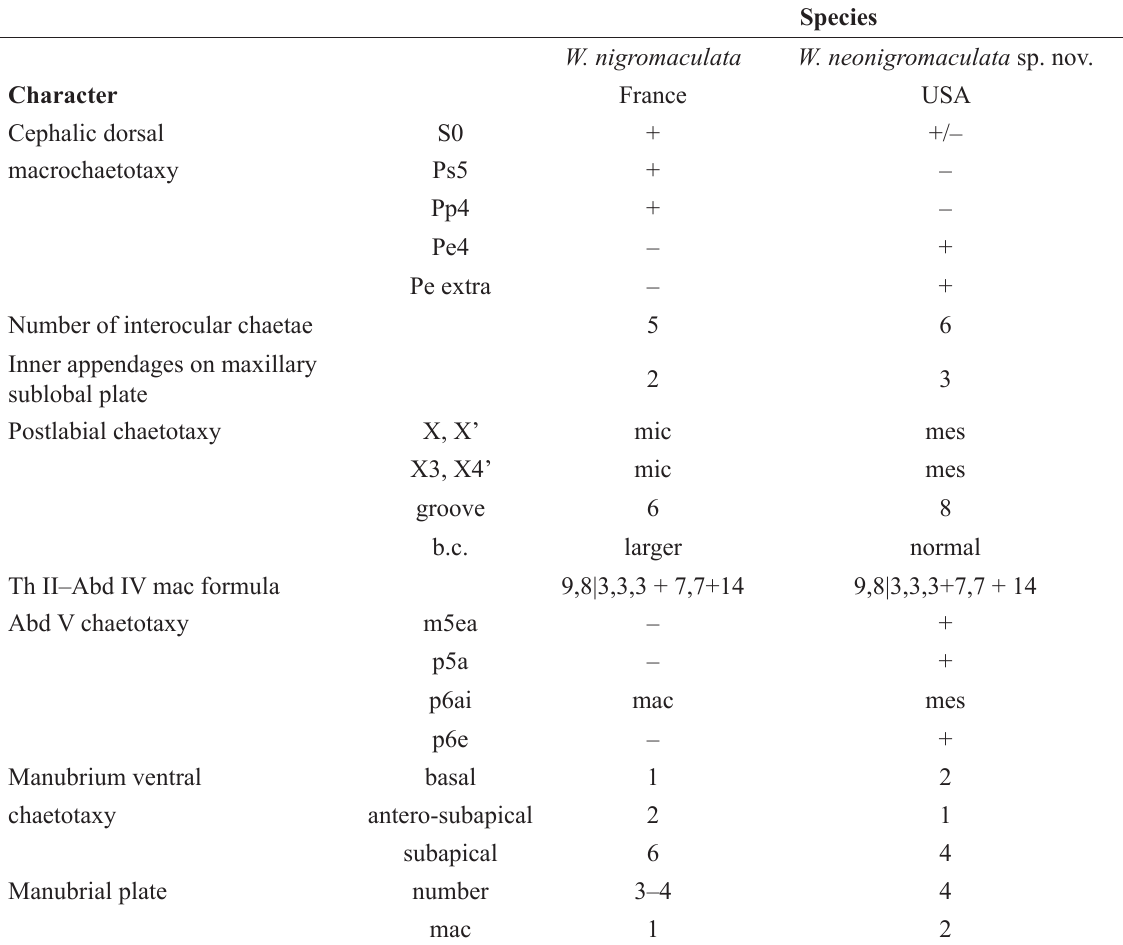
Table 2. Morphological comparison between Willowsia nigromaculata (Lubbock, 1873) and W. neonigromaculata sp. nov. (‘+’ is present; ‘–’ is